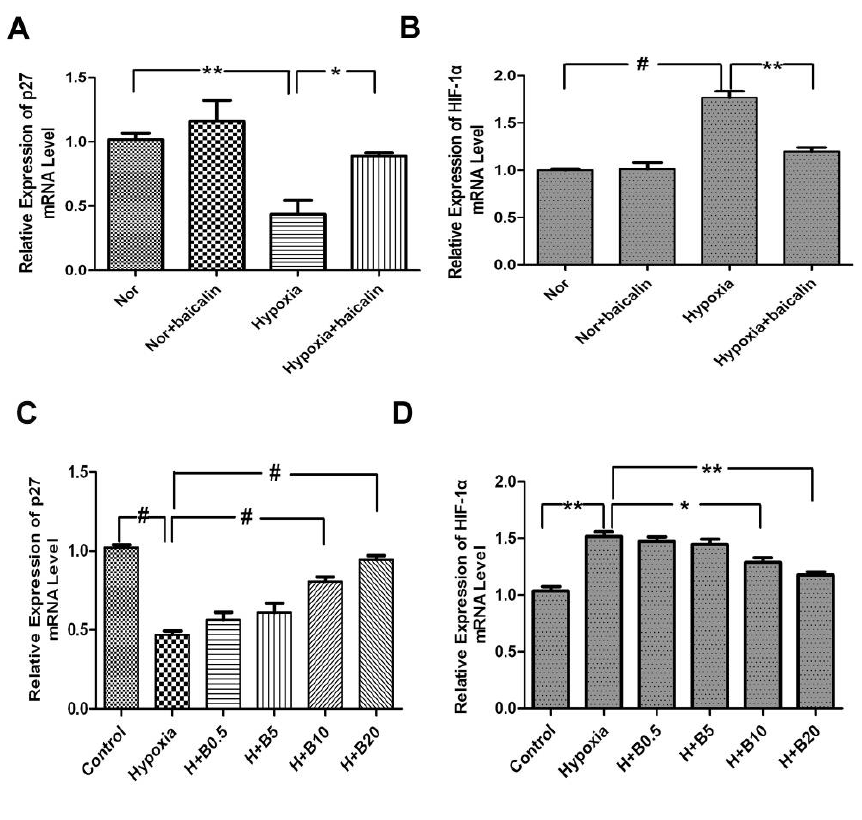
Figure 4. The effects of baicalin on mRNA expression in rat lungs and cultured PASMCs. ( A , B ) Analysis of p27 and HIF-1 α mRNA levels in rat lungs; ( C , D ) Analysis of p27 and HIF-1 α relative mRNA levels in cultured rat PASMCs. “Nor” means normoxia; “H” means hypoxia; “B” means baicalin. ( # p < 0.001; ** p < 0.01; * p < 0.05). All values are